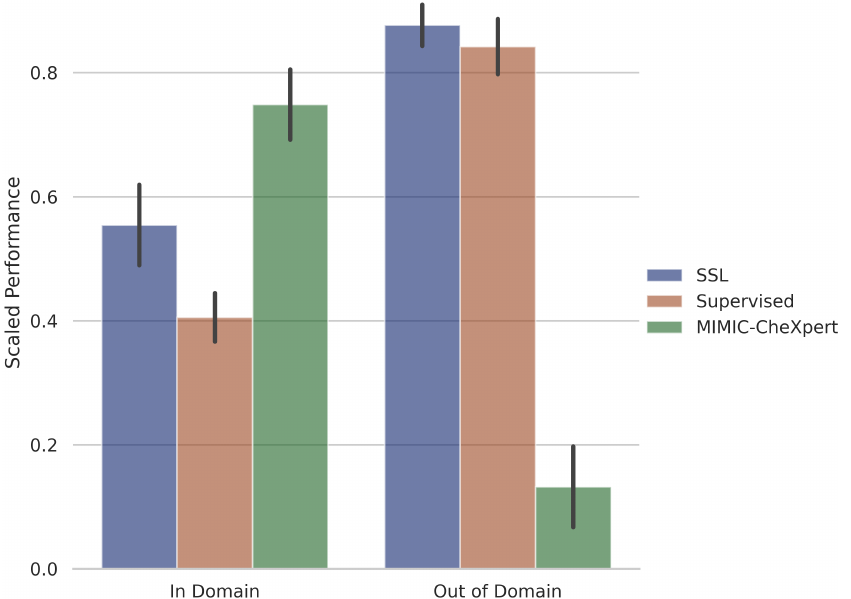
Figure 4. Performance (few-shot, linear, and finetune) on in-domain and out-of-domain datasets for the different model types, Self-supervised learning (pretrained on ImageNet), Supervised and MIMIC- CheXpert. In-domain datasets are comprised of CheXpert, ChestX, Montgomery and Shenzhen, while out-of-domain datasets are comprised of BACH, EyePACS, iChallenge-AMD, iChallenge-PM. Results are scaled between 0 and 1 (across all models), averaged over each model type, and then averaged over each dataset. Error bars correspond to 1 σ variations across the individual models that are averaged